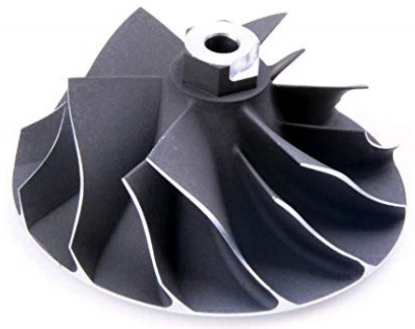
Figure 2. Compressor wheel.